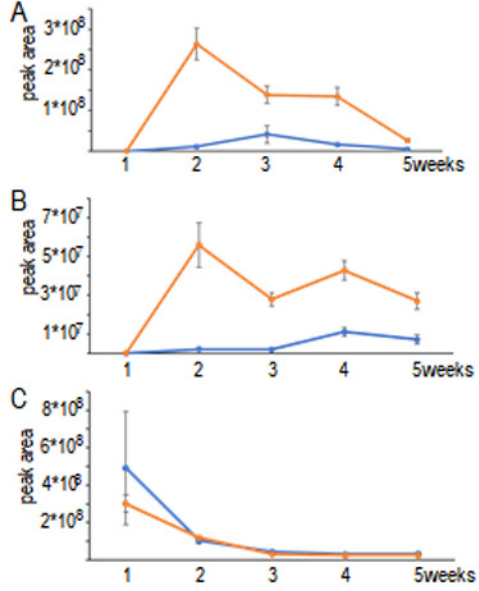
Figure 3. Dynamics of the production of major sesquiterpenes. Quantification in axenic (blue) and ectomycorrhizal (orange) conditions for ( 2 ) ∆ 6 -protoilludene ( A ), (10) β -barbatene ( B ), and the ( 17 ) sesquiterpene ketone ( C ) are given; n = 5.